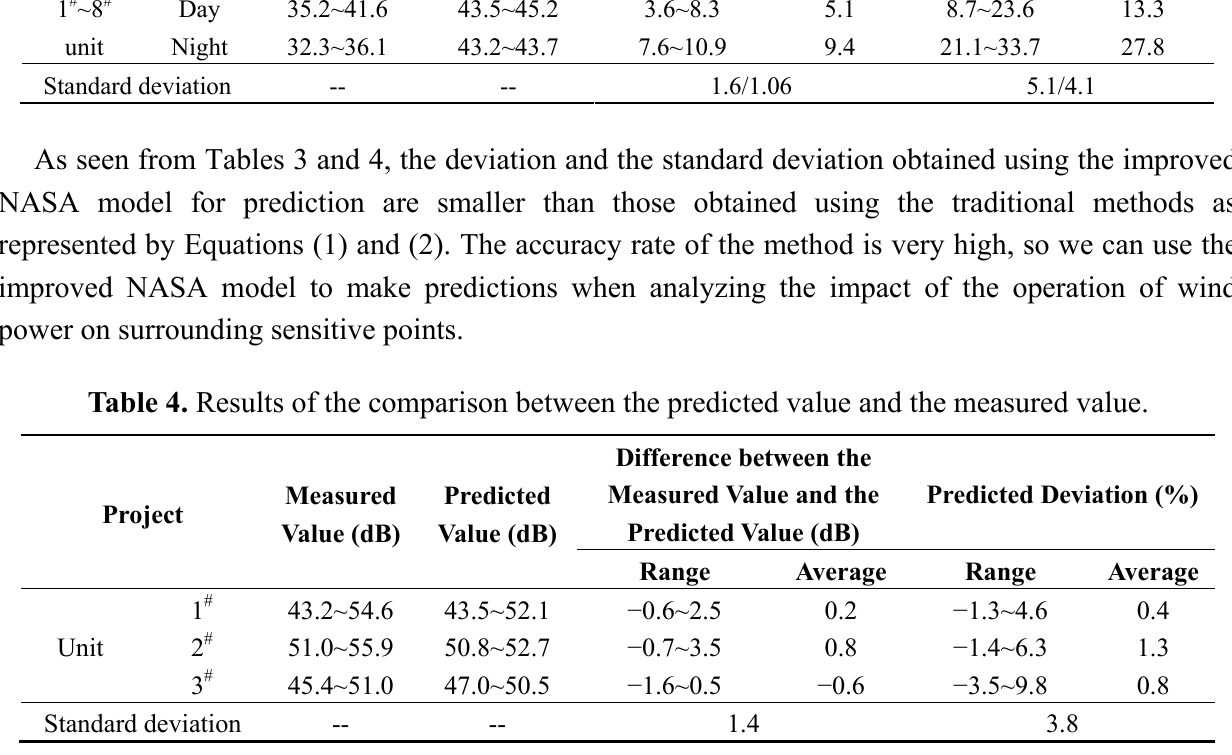
Table 3. Predicted results of statistical analysis of the monitored noise in residential areas. Difference between the Measured Value and the Measured Predicted Project Predicted Value (dB) Values (dB) Values (dB) Range Average Range Average 1 # ~8 # Day 35.2~41.6 unit